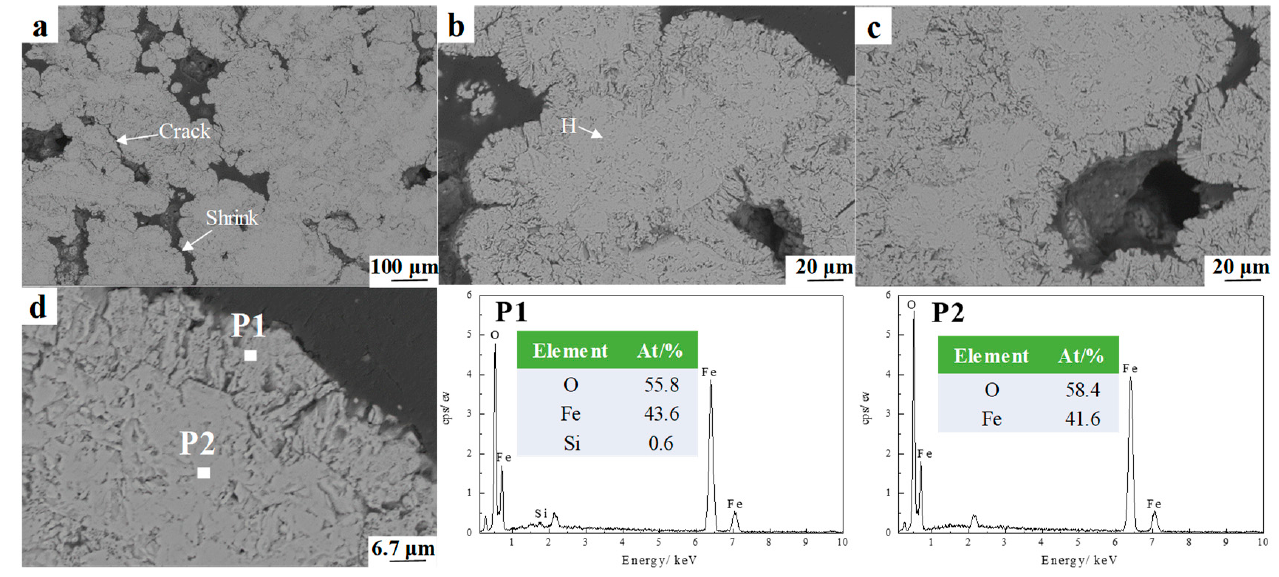
Figure 8. Cracking microstructure of #2 iron ore at 30s of smelting reduction. ( a ) Cracking micro- structure with 100 μ m scale; ( b ) Cracking microstructure with 20 μ m scale; ( c ) Cracking micro- structure with 20 μ m scale ; ( d ) Cracking microstructure with 6.7 μ m scale; ( P1 ) EDS results in (d); ( P2 ) EDS results in (d).